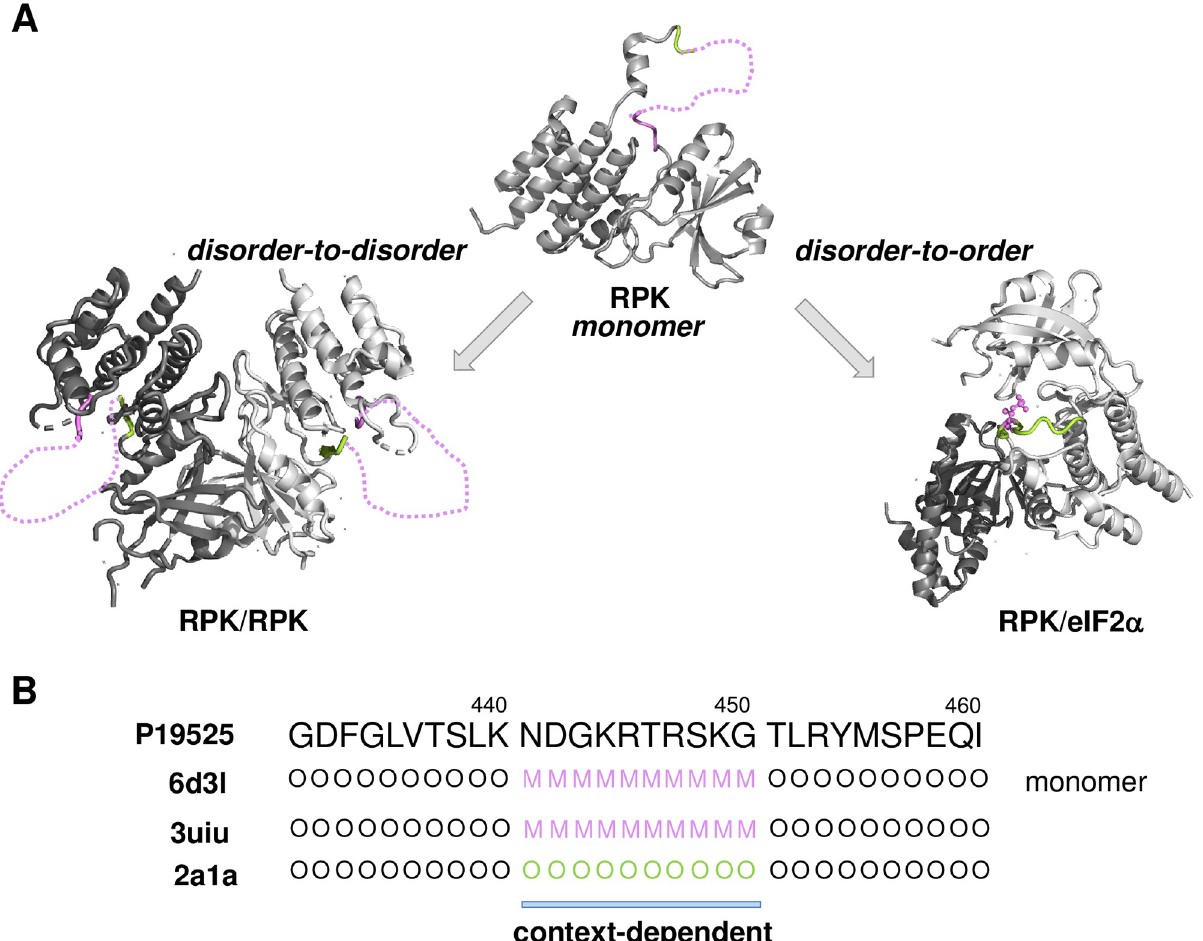
Fig 1. Illustration and assignment of binding modes. (A) Binding modes considered in this work. Binding modes are shown for the interferon- induced, double-stranded RNA-activated protein kinase (RPK). The activation segment (residues 440–450) is not visible in the crystal structure of the monomeric form (PDB: 6d3l [52]), and remains disordered in the dimeric form (PDB: 3uiu, 6d3k). This binding mode represents a disorder-to- disorder transition. Interactions with eukaryotic initiation factor 2 (eIF2), however, triggers folding of the activation segment to mediate inter- molecular contacts (PDB:2a1a [53]), which process is coupled to auto-phosphorylation of Thr446. The RPK binding to eIF2 is classified as a disorder- to-order transition. (B) Assignment of context-dependent binding. Structures corresponding to the same sequence (P19525, residues 440–460) were collected in the monomeric and complex forms. Residues were observed (O) in the crystal structures were assigned as ’ordered’, missing residues (M) were assigned as disordered. ’Context-dependent’ residues (blue bar) were disordered in the monomeric form, but were represented both in ordered and disordered forms in different complexes. ’Disorder-to-order’ residues were disordered in the monomeric structure and ordered (O) in all complexes; whereas ’disorder-to-disorder’ residues also remained to be disordered (M) in all bound state structures.